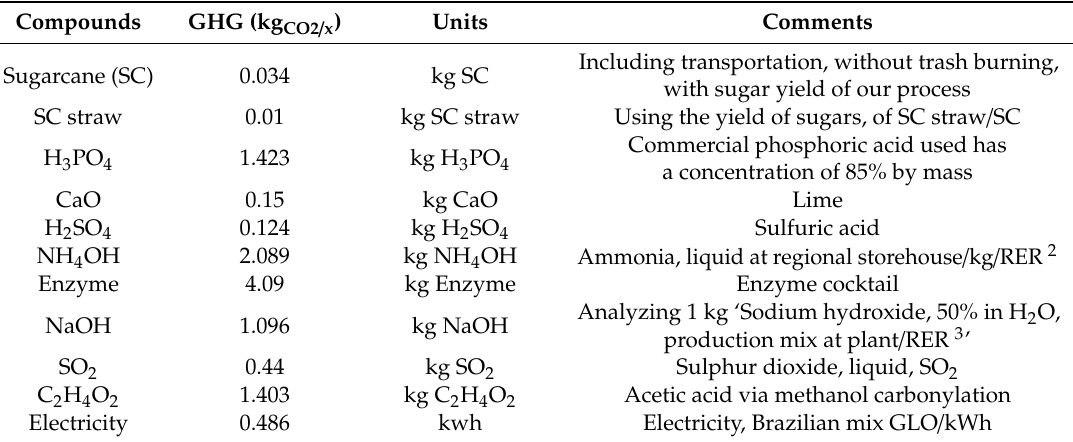
Table A11. Life cycle inventory data 1